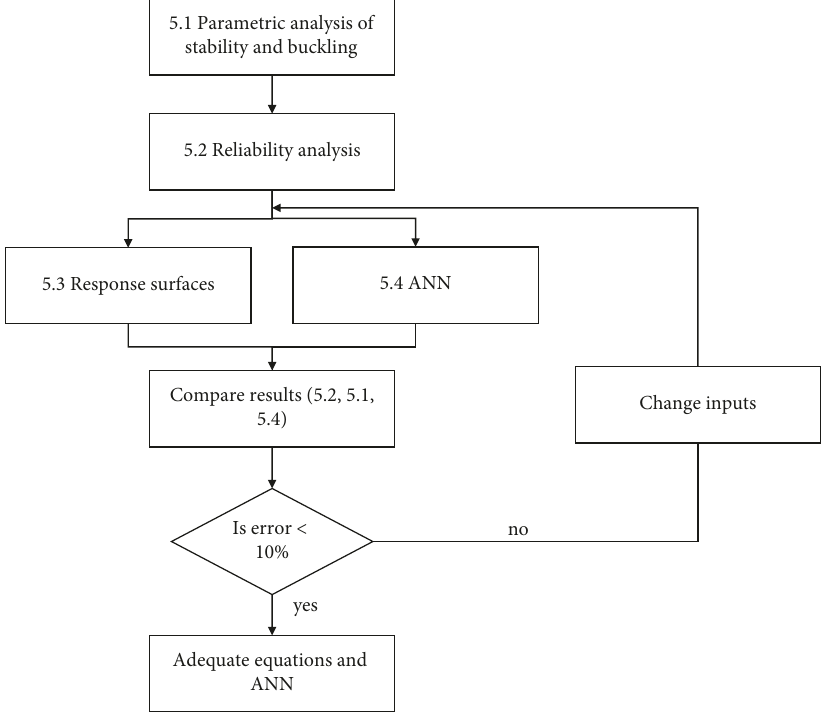
Figure 2: General methodology.